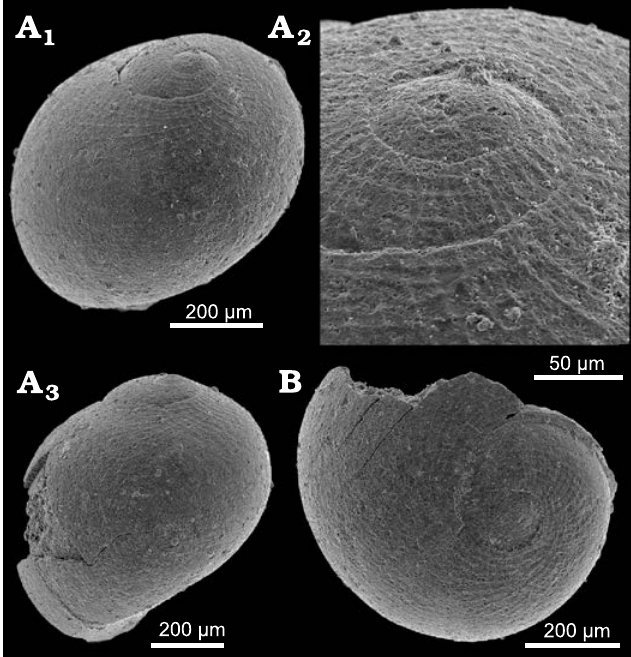
Fig. 8. Neritariid gastropods Neritaria mandelslohi (Klipstein, 1843) from Lago Antorno, northern Italy, Cassian Formation, Carnian, Upper Triassic. A . PZO 12798, in oblique lateral (A 1 ) and lateral view (A 3 ), and oblique lateral view of protoconch (A 2 ). B . PZO 12799 in apical